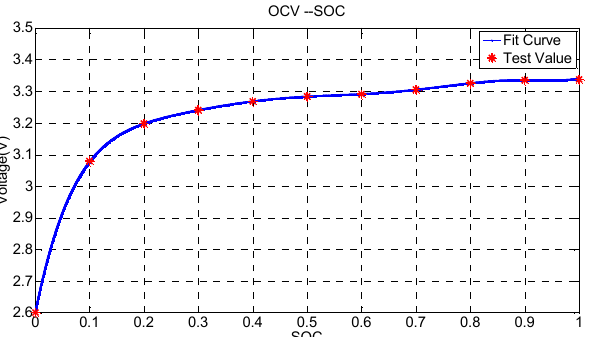
Figure 4. Open circuit voltage (OCV) curve with respect to state of charge ( SOC ).